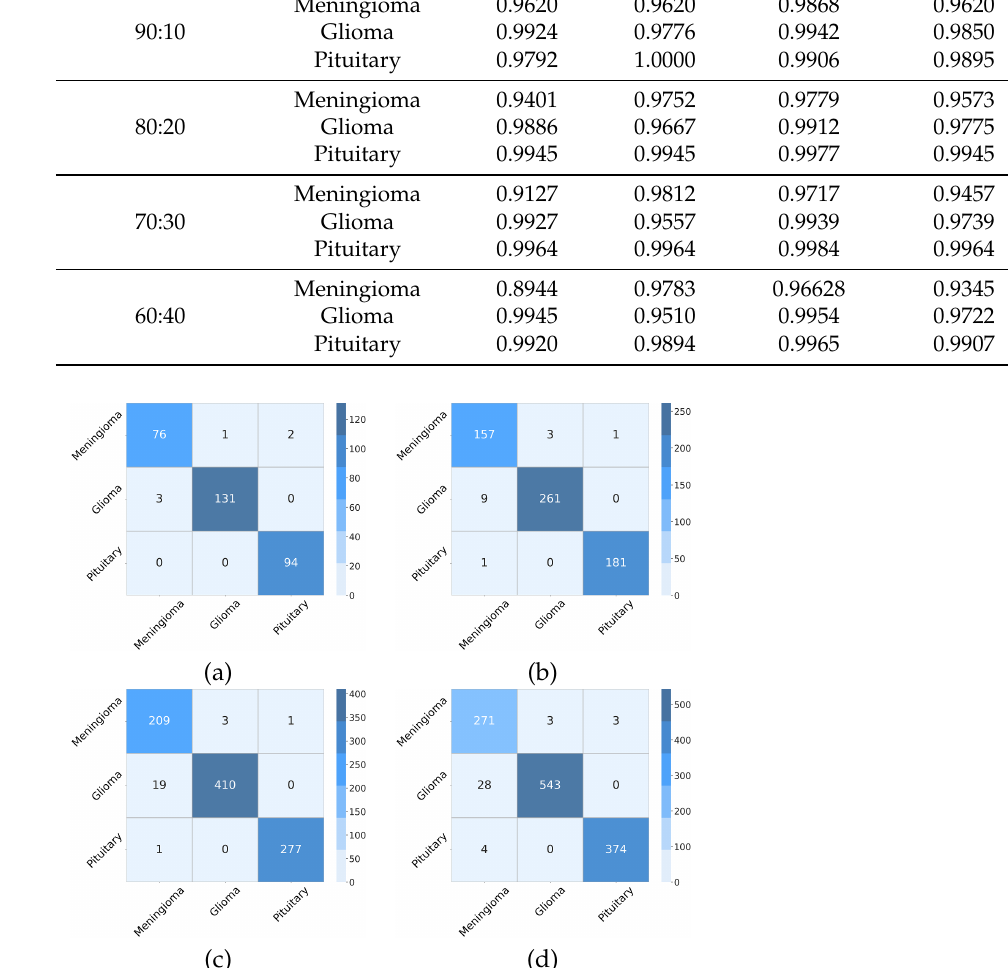
Figure 12. The confusion matrixes derived from the proposed model on BT-3C with different partition ratios. ( a ) 90:10, ( b ) 80:20, ( c ) 70:30, ( d )